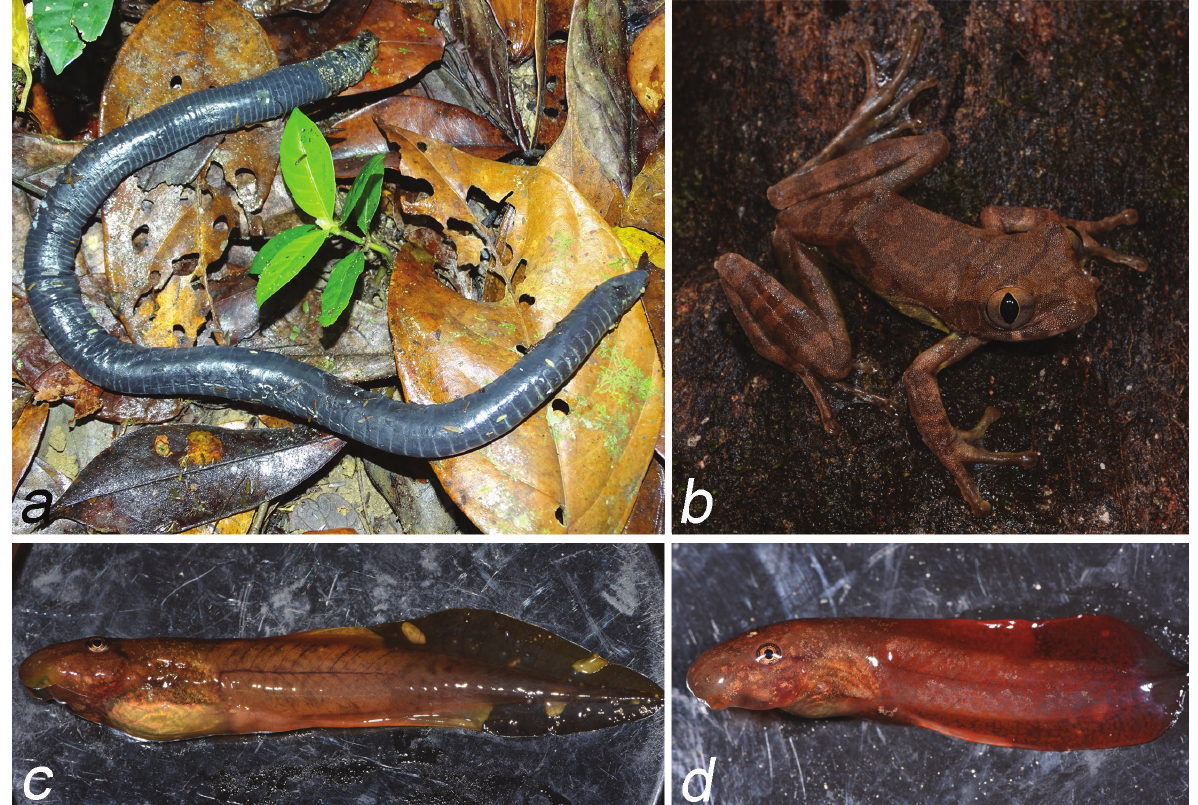
Figure 2. a Geotrypetes sp. (ZMB 88492) found dead in the leaf litter in KBPPA b Leptopelis macrotis male (ZMB 88439) from KBPPA c , d Conraua alleni tadpoles (ZMB 88526) from the same puddle in a small stream in FPPA, take note of the differing color, shape and place of insertion of tail